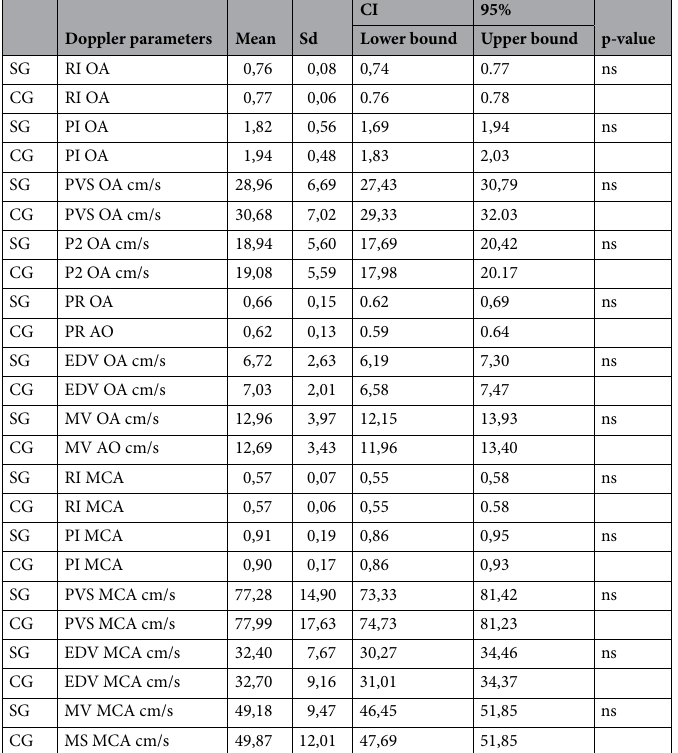
Table 2. Comparison between means and standard deviation of Doppler indexes in the ophthalmic and middle cerebral arteries of smoking and non-smoking men. OA Ophthalmic Artery, MCA Middle Cerebral Artery, MV mean velocity, RI Resistance Index, PI Pulsatility Index, PVS Peak of Velocity Systolic, P2 second peak of velocity, PR peak ratio, EDV End Diastolic Velocity, SG study group, CG control group, cm/s centimeter/second, sd standard deviation, ns non